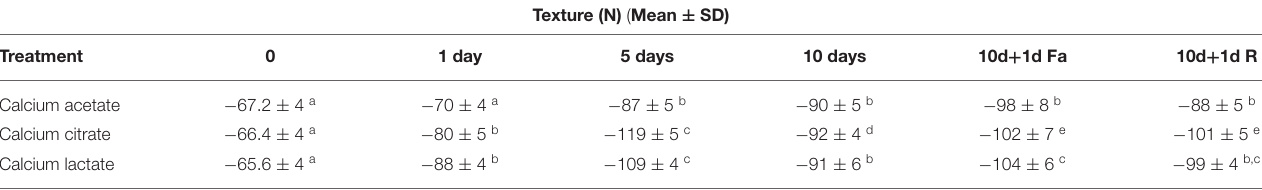
TABLE 3A | Texture values during time course treatment of JFSW in brines with calcium acetate, citrate, and lactate at 1, 5, and 10 days. Texture (N) ( Mean ± SD)